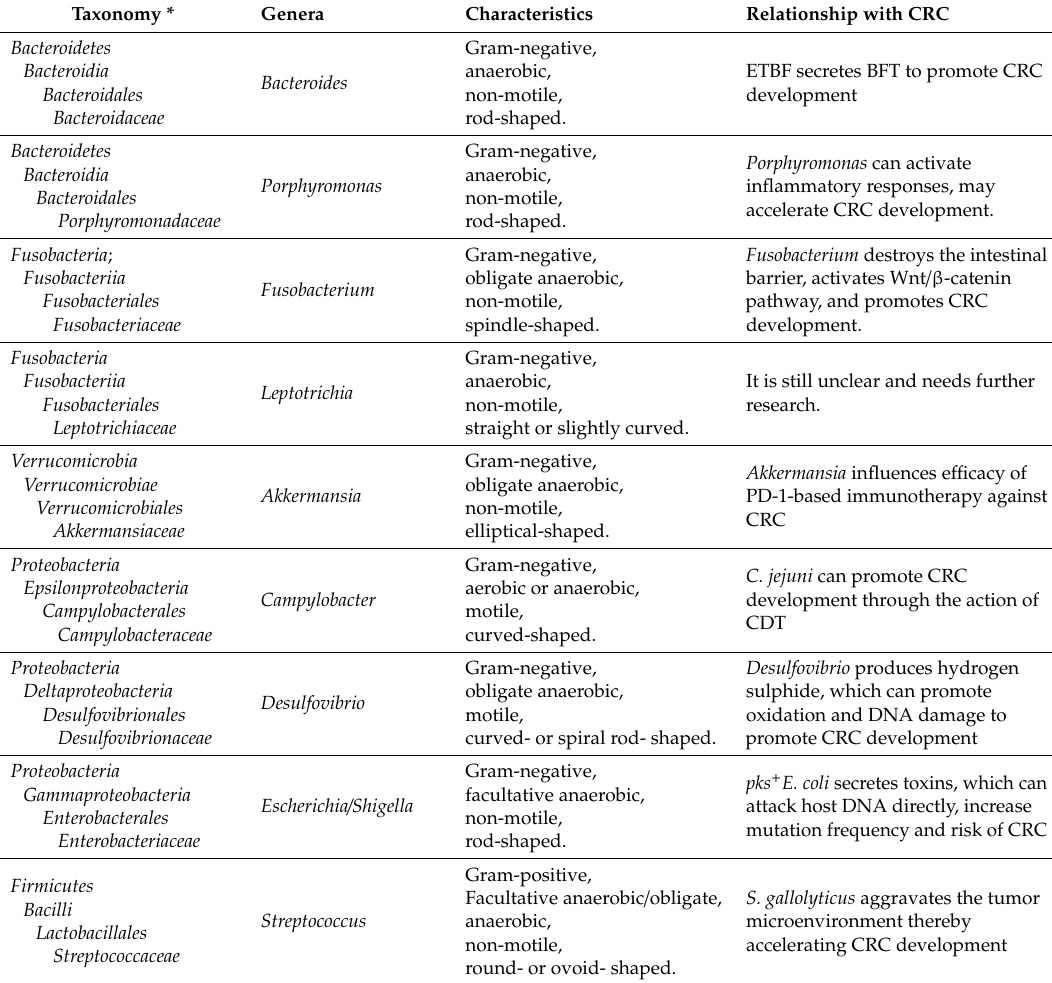
Table 3. Basic characteristics of twelve genera of